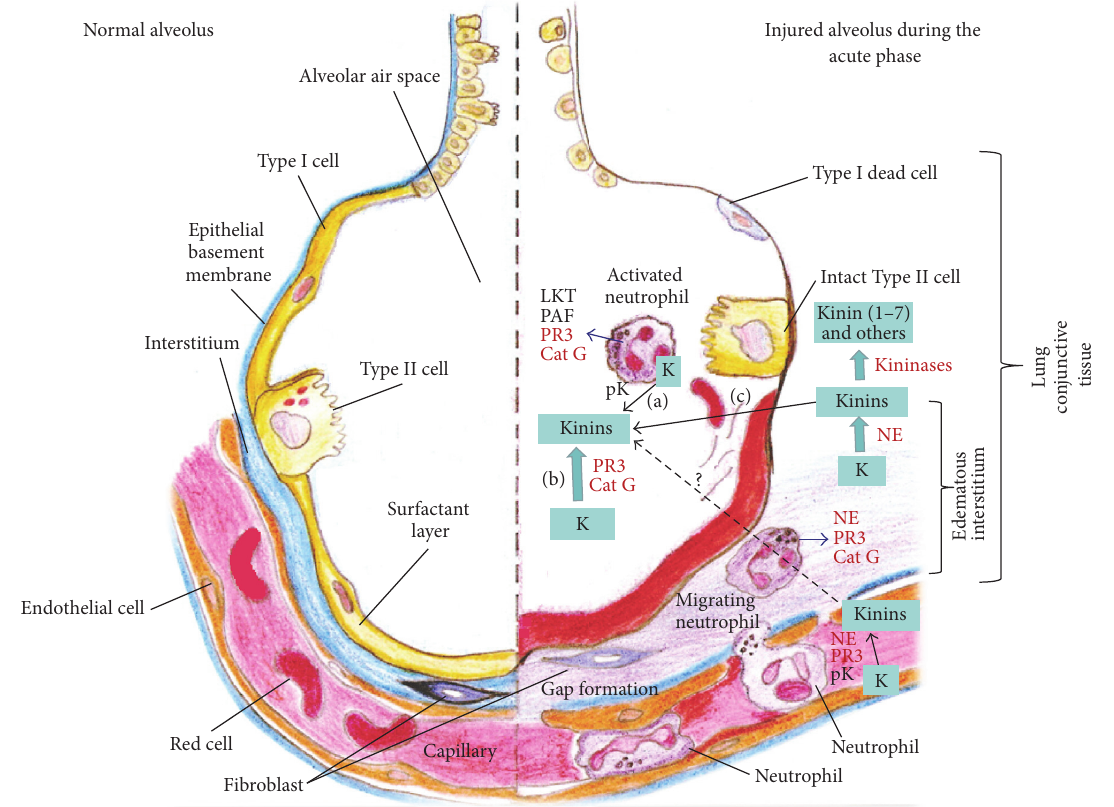
Figure 4: Potential sources of kinin in LPS-induced lung inflammation model. Kinin may be generated in lung via kininogen hydrolysis and is rapidly degraded by kininases. This peptide can be released into the alveolar space through distinct pathways: (a) in neutrophil- bound kininogen cleavage by plasma kallikrein, (b) kininogen hydrolysis by NE and PR3, or (c) diffusion from the lung interstitium to the alveolar space. In the plasma, pK, PR3, and NE all release kinin. Additionally, kinin might be exchanged between plasma, lung, and alveolar space. K: kininogen (high-molecular-weight, low-molecular-weight, and/or T-kininogen); pK: plasma kallikrein; NE: neutrophil elastase; PR3: proteinase 3; BALF: bronchoalveolar lavage fluid; LKT: leukotrienes; PAF: platelet activator